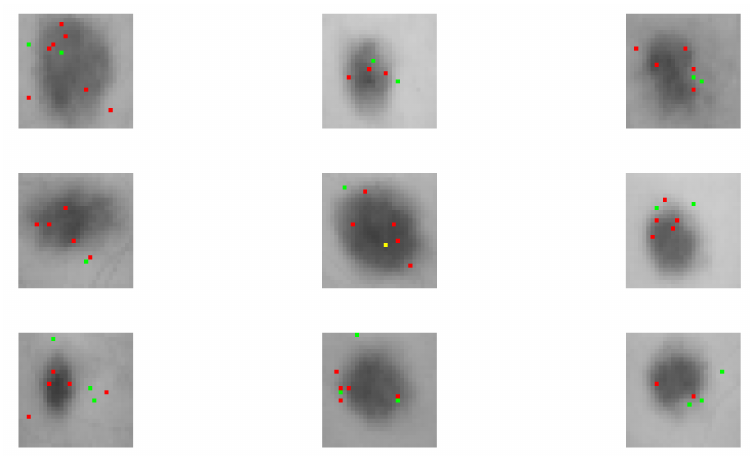
Figure 8. Centroids of nine rules with their antecedents generated from R 7 in the fully connected layers.